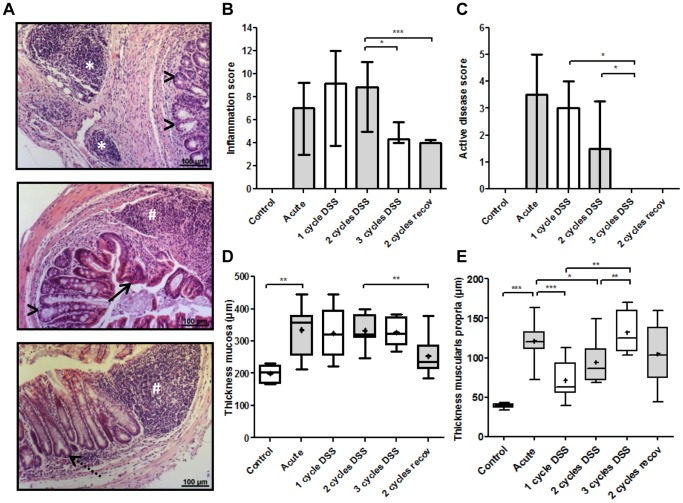
Histological read-outs of colitis.(A) Representative pictures of colon sections from mice after 2 and 3 cycles of DSS exposure. The repeated cycles of DSS induce persistent and dense infiltration of deeper layers with mononuclear cell aggregates in the subserosa (*), crypt dilatation (>), re-epithelialization (→) and crypt fission (dotted →). (B) Microscopic inflammation score. Three sections per animal were evaluated. The details of this score are shown in supplementary figure 1. Data are expressed as medians with IQR. (C) The lower degree of inflammation after 3 cycles and 2 cycles with prolonged recovery is associated with a lower histological active disease score. The histological active disease score comprised the sum of neutrophil infiltration and epithelial defects, expressing the activity of disease and the potential for acute tissue damage during the last 24 hours prior to tissue sampling. (D) Thickness of the mucosa and (E) thickness of the muscularis propria. Two sections per animal were evaluated. The mean is annotated as +. Data are expressed as box and whiskers and 5–95 percentile are plotted. Mann-Whitney U testing (*p<0.05, **p≤0.01, ***p≤0.001).